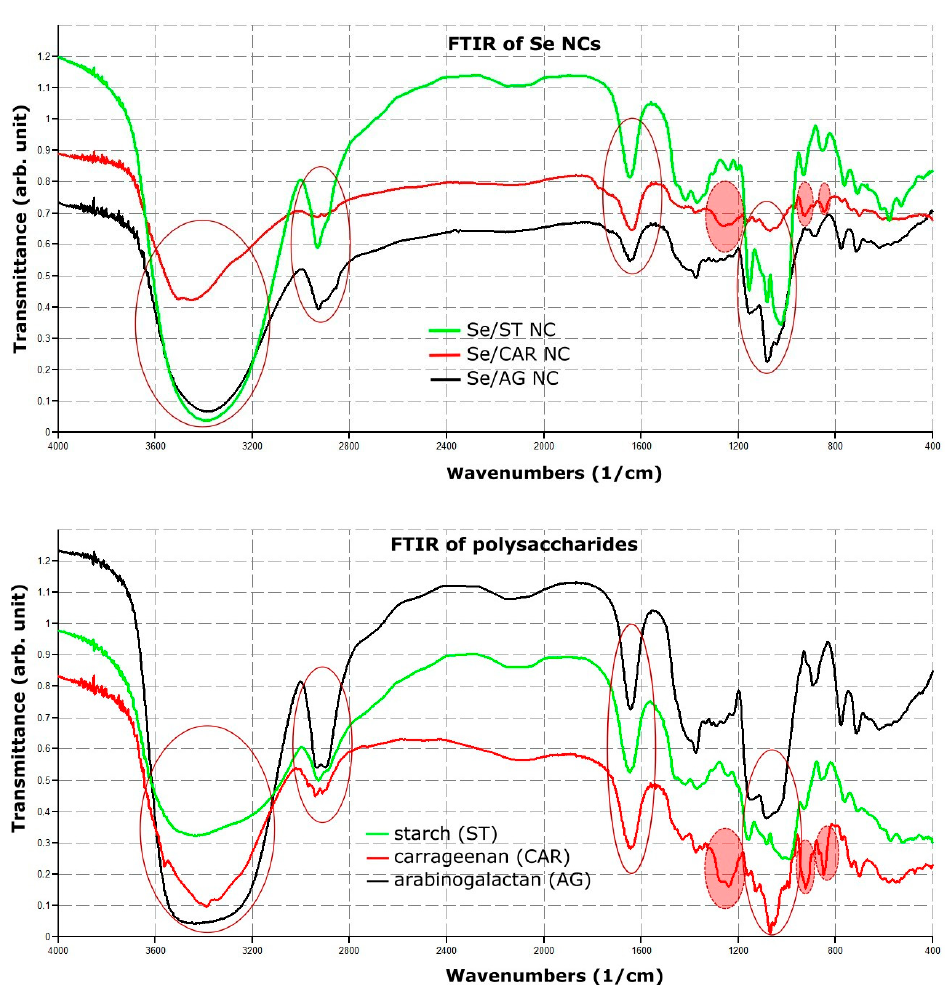
Figure 1. Fourier-transform infrared (FTIR) absorption spectra of all Se NCs and their polysaccharides. Continuous ovals depicted four intense IR absorption regions that were almost the same for all Se NCs in our study. Dotted solid red ovals depicted three additional IR absorption regions specific for CAR and Se/CAR NC.